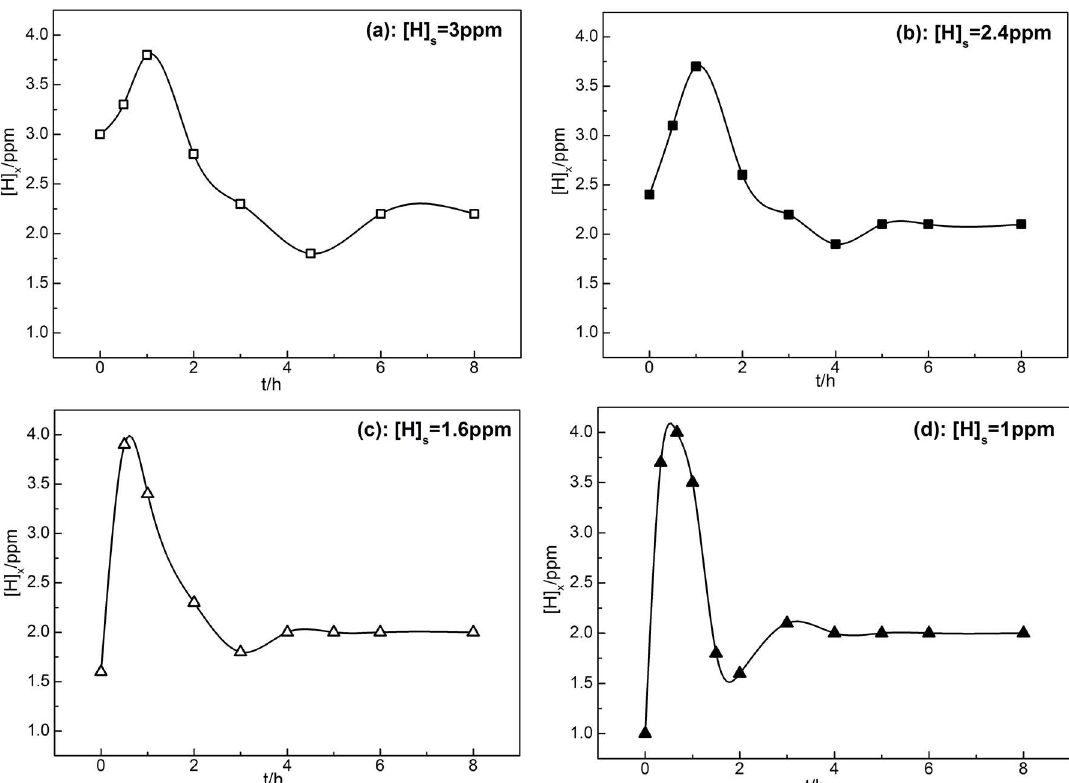
Figure 2. Influence of initial hydrogen content on hydrogen content in steel during